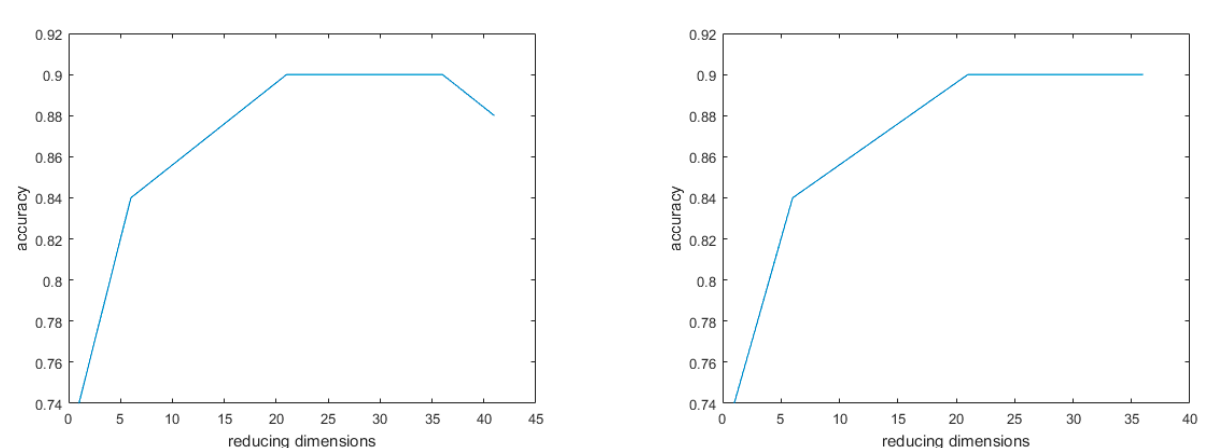
Figure 4. Number of iterations and classification accuracy of SAE model. Note: The accuracy after 100 iterations was 98.25% and the average error was 1.75%; after 55 iterations the accuracy rate was 94.82% and the average error was 5.18%.